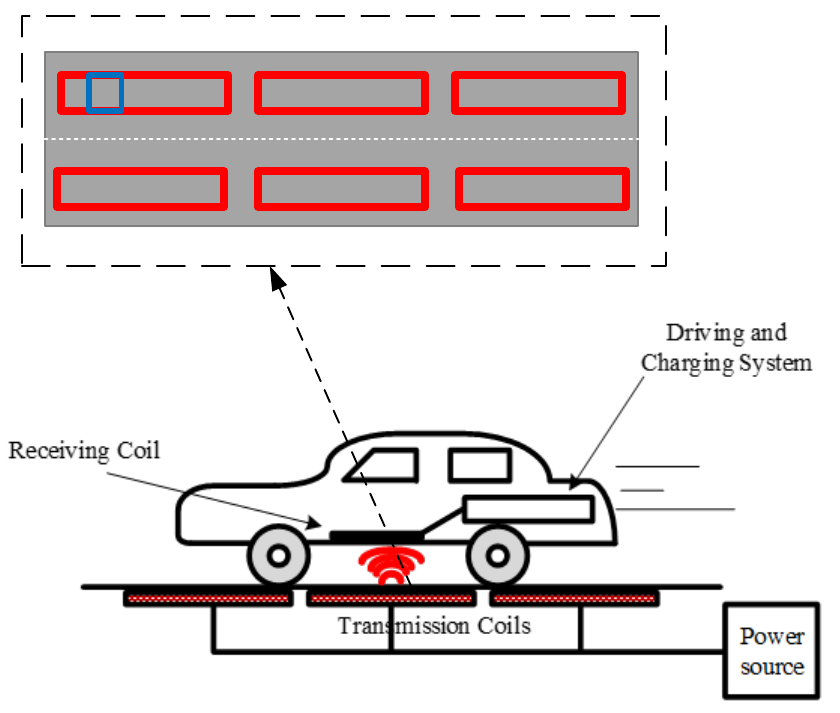
Figure 5. Schematic of EV dynamic charging system.